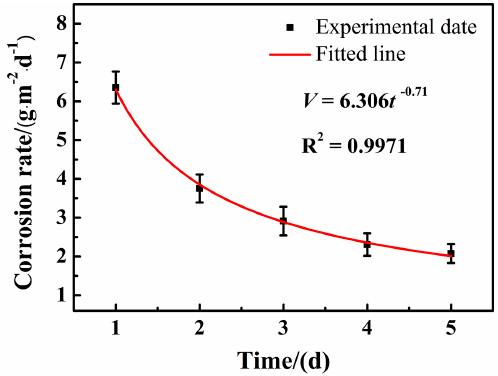
Figure 1. Corrosion rates of 12Cr1MoV steel for different corrosion times.